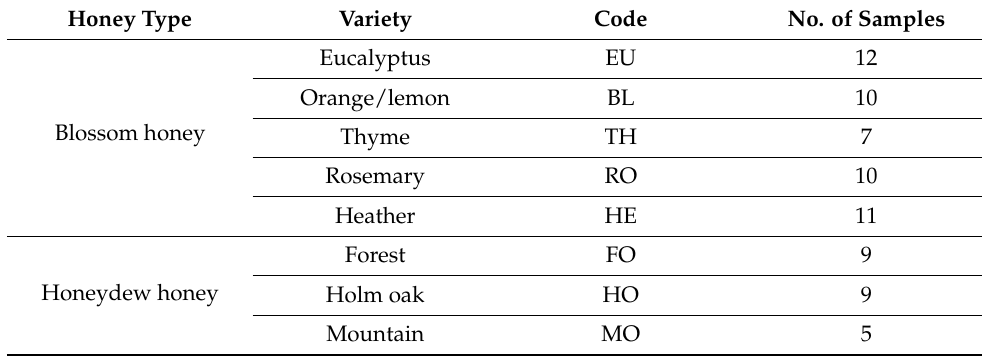
Table 1. Blossom and honeydew honeys analyzed. Honey